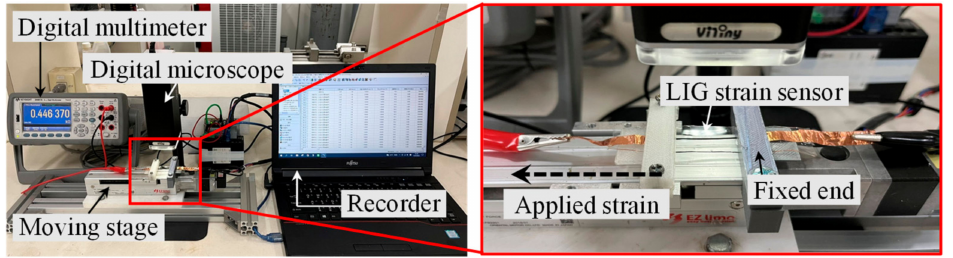
Figure 5. Measurement setup for the response of the stretchable LIG strain